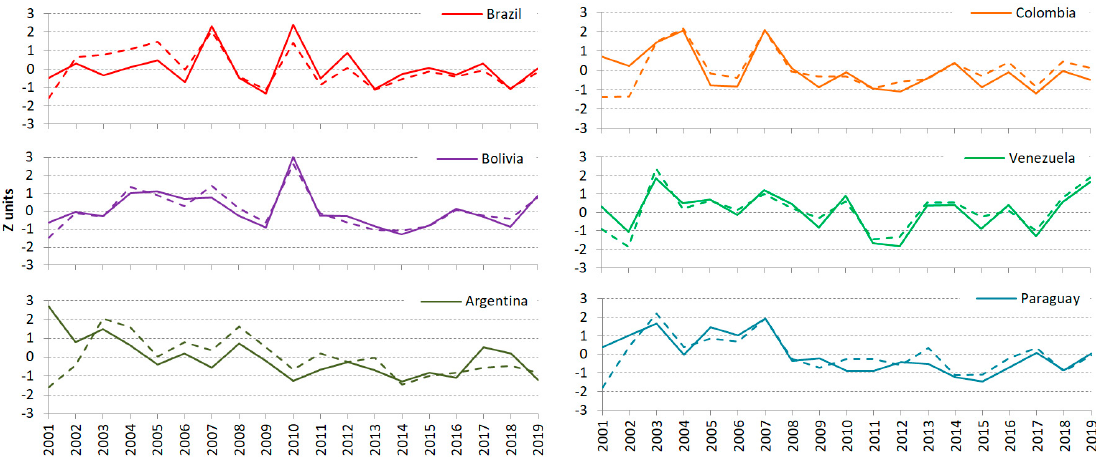
Figure 2. Country anomalies of BAs (solid line) and AFs (dotted line) for the 2001–2019 period (considering only from January to October).